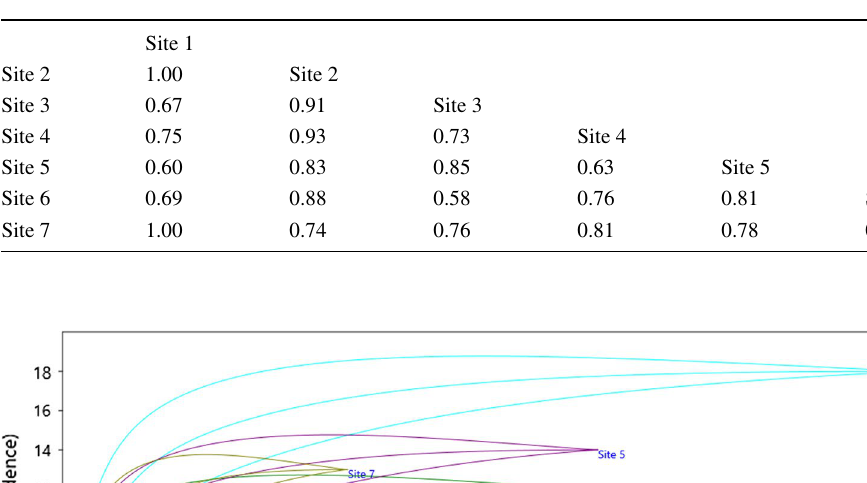
Table 2. The species diversity H ′ (log are high in Site 4, Site 5, Site 7 and Site 3 and low at Site 1 and Site 2. But except Site 7, J ′ showed a reverse trend.